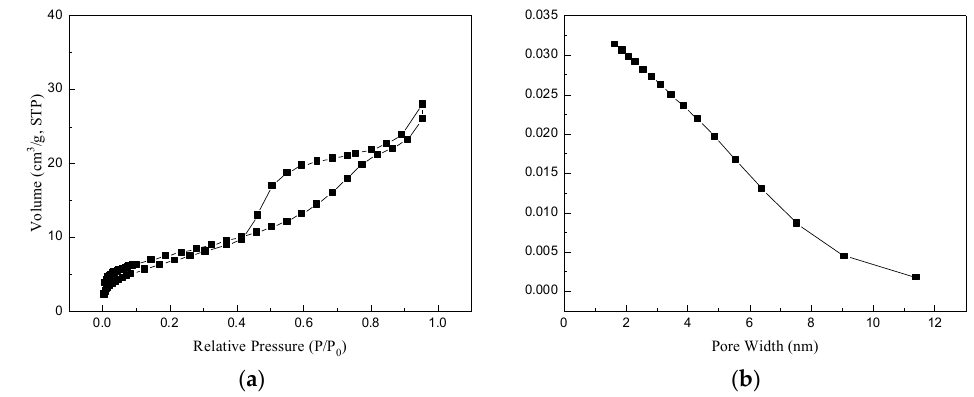
Figure 5. ( a ) BET nitrogen adsorption-desorption isotherm and ( b ) pore size distribution curve of TiO 2 -P25 materials.